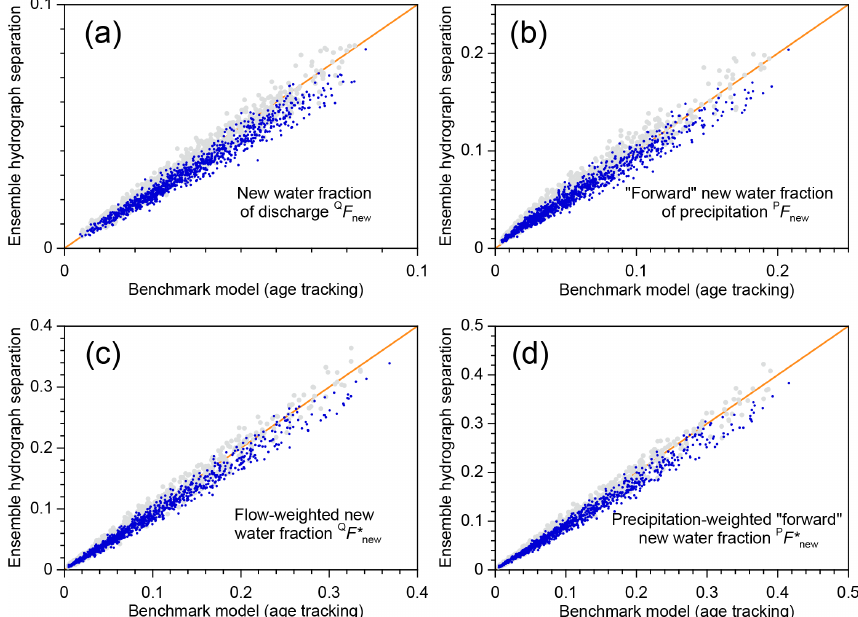
Figure 10. Effects of seasonally varying evaporative fractionation on new water fractions estimated by ensemble hydrograph separation. Points show new water fractions predicted from tracer fluctuations in precipitation and streamflow (on the vertical axis), compared to averages of time-varying new water fractions determined by age tracking in the benchmark model (on the horizontal axis). Blue points show 1000 model runs in which precipitation undergoes seasonally varying evaporative fractionation ranging from zero in winter to 20‰ in summer. Gray background points show 1000 model runs without evaporative fractionation (analogous to Fig. 2). Each model run has a different random set of model parameters, measurement errors, and missing values, but the precipitation driver (Smith River daily precipitation) is the same in all cases. The blue data clouds closely follow the 1 : 1 line, indicating that ensemble hydrograph separation can reliably estimate new water fractions even in the presence of substantial evaporative